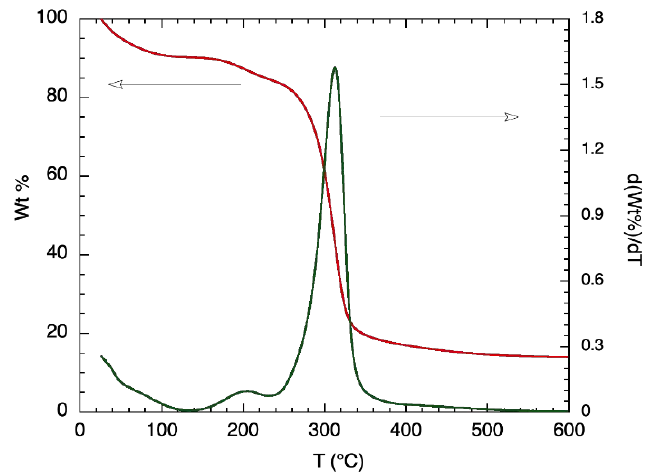
Figure 2. TGA (red line; left y-axis) and di ff erential TGA (green line; right y-axis) thermogram of purified alpha-glucan polysaccharide glucansucrase.